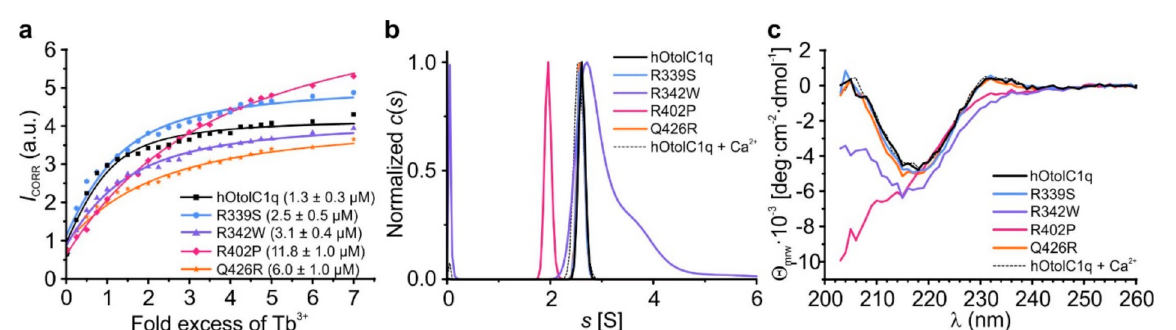
Figure 5. Binding of Tb 3+ by hOtolC1q and its variants, analyzed by fluorometric titration, sedimentation velocity analytical ultracentrifugation and circular dichroism. ( a ) The results of a titration experiment, in which 3.7 µ M proteins were treated with appropriate excess of TbCl 3 . The fluorescence intensity data were measured 15 min after addition of each portion of Tb 3+ , corrected for background fluorescence and fitted to a single binding site per monomer model. Apparent K d values are given in the parentheses in the legend. ( b ) The c ( s ) distributions calculated from sedimentation velocity data obtained for 0.25 mg/mL (14.7 µ M) hOtolC1q variants in the presence of 7-fold molar excess of TbCl 3 . The distributions for R339S and Q426R variants overlap with that calculated for hOtolC1q. Distribution of hOtolC1q with 10 mM Ca 2+ is shown as a dashed line in the background for comparison. ( c ) The circular dichroism spectra recorded for 0.2 mg/mL (11.8 µ M) hOtolC1q variants in the presence of 7-fold molar excess of TbCl 3 . Spectrum obtained for hOtolC1q with 10 mM Ca 2+ is shown in the background as a dashed